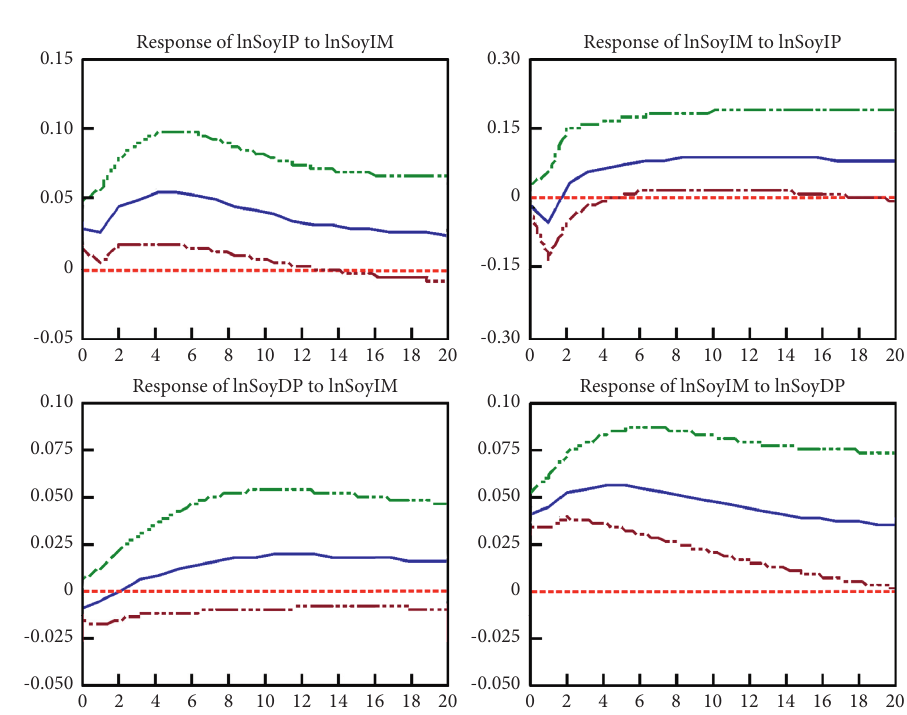
Figure 9: Pulse response analysis results for soybean.